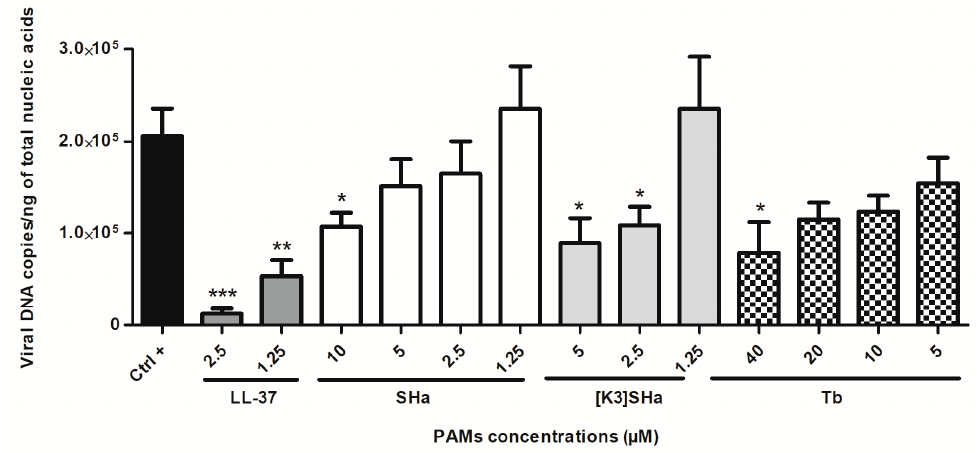
Figure 2. Herpes simplex virus type 1 (HSV-1) replication in human primary keratinocytes treated with LL-37, SHa, [K 3 ]SHa and Tb. Primary keratinocytes were treated with the four AMPs at various concentrations for 1 h before being infected with HSV-1 at an multiplicity of infection (MOI) of 0.1 for 24 h. Viral DNA concentrations were determined in cell lysates by qPCR assay and expressed as viral DNA copies per ng of total cellular nucleic acids extracted from infected keratinocytes. Data are represented as mean + SEM of at least four independent experiments. * p < 0.05, ** p < 0.01 and *** p < 0.01 compared with the infected control without AMPs.